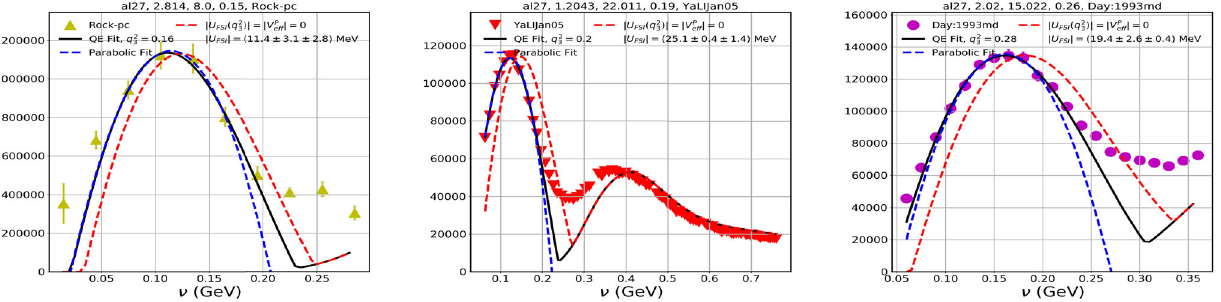
Fig. 11 Same as Fig. 8 for three out of seven 27